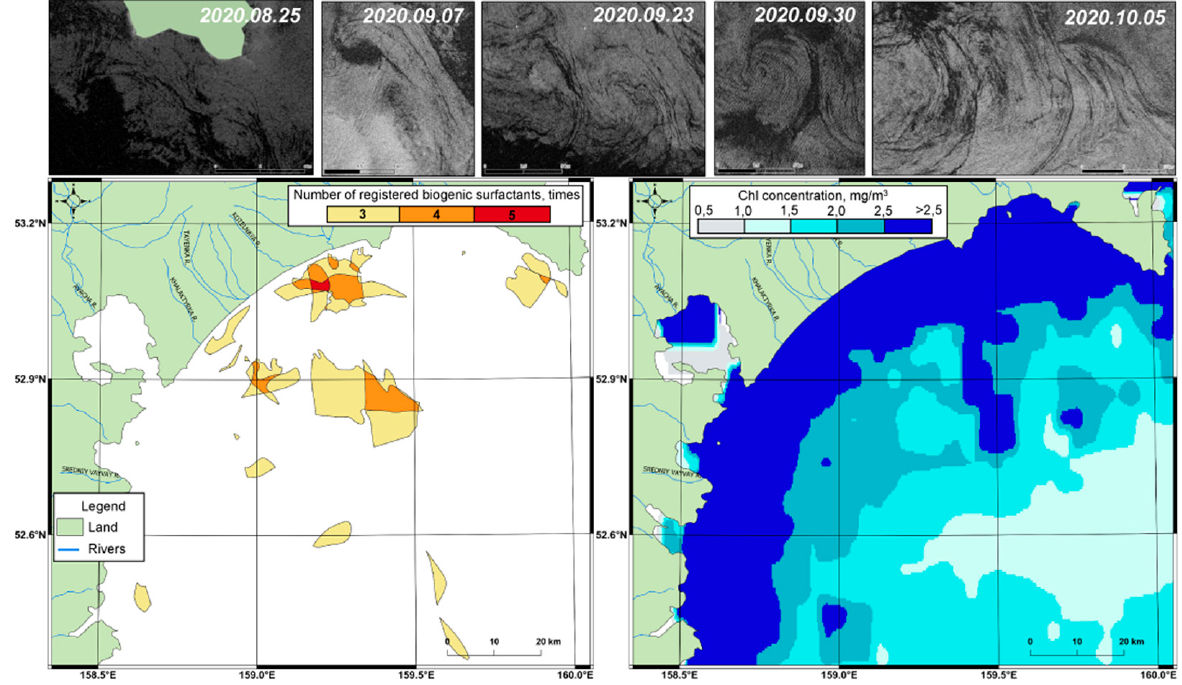
Figure 8. Radar satellite image interpretation result (Sentinel-1A/B) (the images were obtained between 25 August and 5 October 2020). The map of zones of increased accumulation of biogenic surfactants in the Avacha Gulf (left). Right, the map of chlorophyll-a concentration distribution (NOAA VIIRS) averaged over the period from 25 August to 5 October